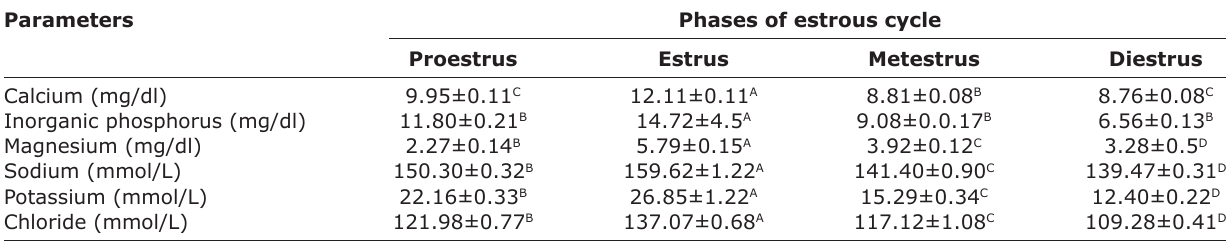
Table-1: Mean±SE values of salivary electrolytes during different phases of estrous cycle in Murrah buffaloes.